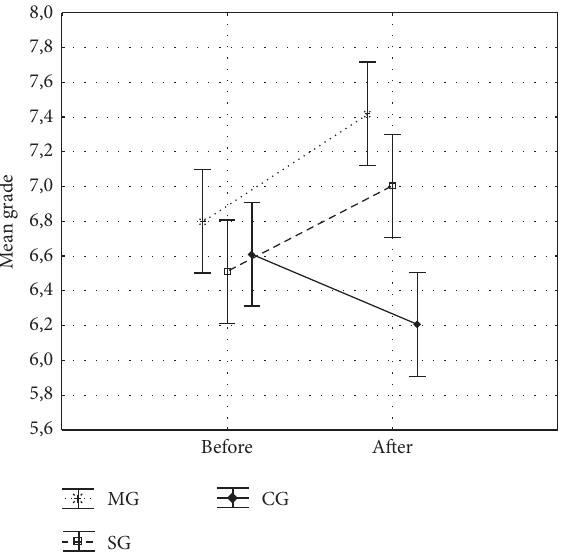
Figure 3: Mean grade obtained by each group before and after the intervention. Before the intervention: the exams of the last week of April were considered. After the intervention: the exams of the last week of September were